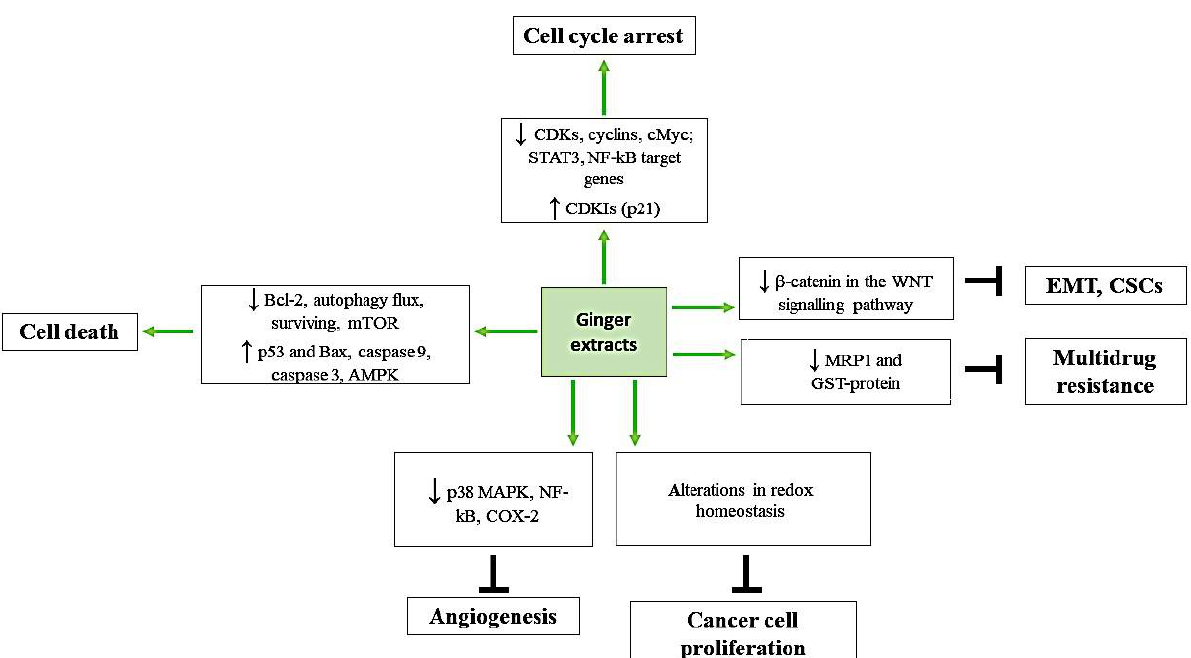
Figure 3. A schematic diagram showing main molecular targets of ginger derivatives. The natural compound participates in the cell cycle arrest by inhibiting the expression of cyclins, CDKs, and levels of STAT3, NF-kB target genes, and by activation of cell cycle check points and increased expression of p21. Moreover, by increasing Bax/Bcl-2 ratio outburst of cytochrome C, activating AMPK, and by decreasing autophagy flux and survivin expression, ginger derivatives provoke cancer cell death. They participate in the alteration of redox homeostasis, which stops cancer cell proliferation. By blocking activation of p38 MAP kinase (p38 MAPK) and NF-kB, ginger derivatives inhibit COX-2 expression and as a result block angiogenesis. Ginger extracts decrease β-catenin in the WNT signaling pathway, which leads to the inhibition of gene transcription, involved in EMT and CSCs, and, additionally, downregulate MRP1 and GST-protein expression, involved in multidrug resistance.